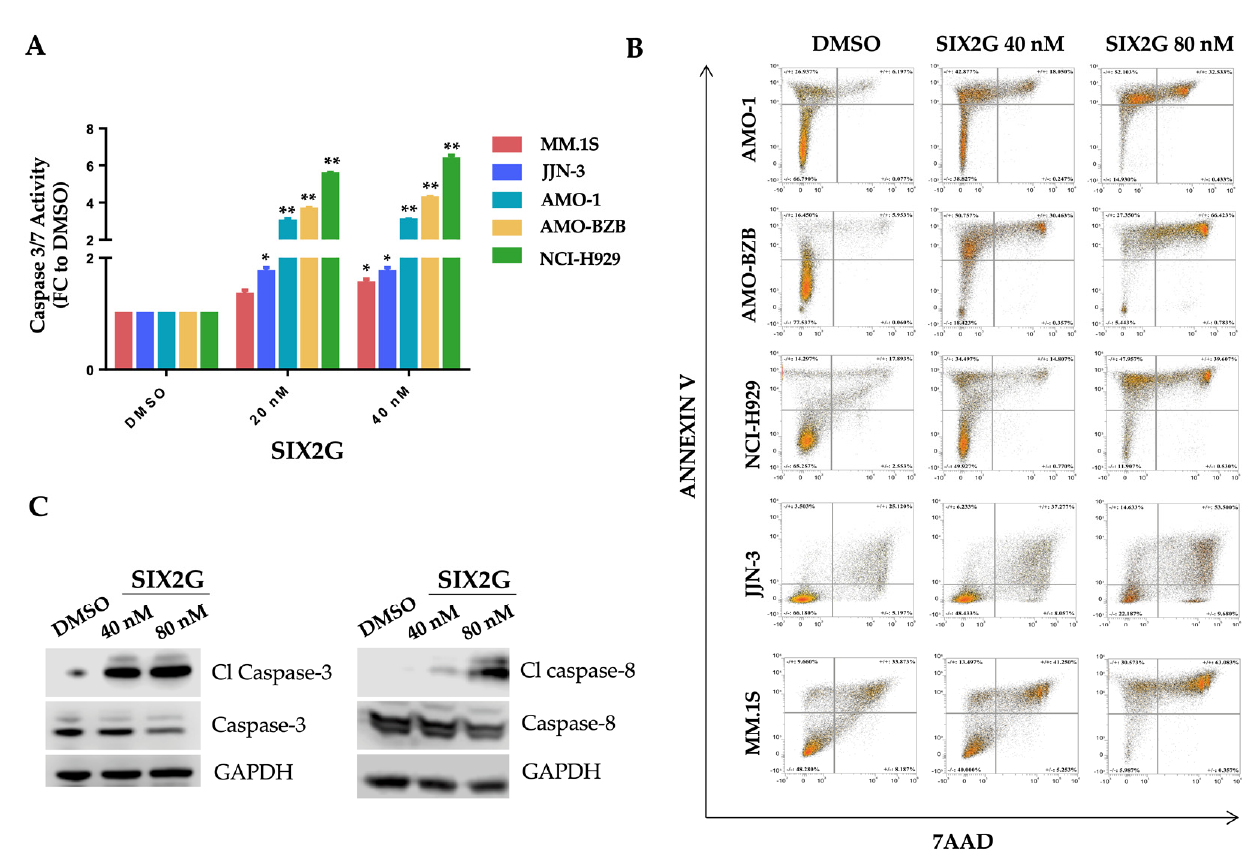
Figure 4. Apoptosis Assays. The activation of caspases-3 and caspase-7 was evaluated through the Caspase Glo ® assay. Histogram bars represent mean ± SD of the fold changes (FC) of absorbance values of SIX2G treated cells respect than cells treated with DMSO ( A ). Dot plots in figure ( B ) represent the distribution of cells treated for 24 h with DMSO or SIX2G at the indicated concentrations, following Annexin V/7AAD staining ( B ). Representative WB analysis of caspase-3, caspase-8, cleaved (Cl) caspase 3 and Cl-caspase 8 detected on AMO-1 cells 24 h after SIX2G treatment at the indicated concentrations. GAPDH was used as loading control ( C ) (Whole WB images and densitometry analyses are reported in Supplementary Information). Student’s t -test was applied to calculate the statistical significance between multiple group comparisons, respect than DMSO treated cells. p -value < 0.05 is indicated with one star (*), p -value < 0.01 with two stars